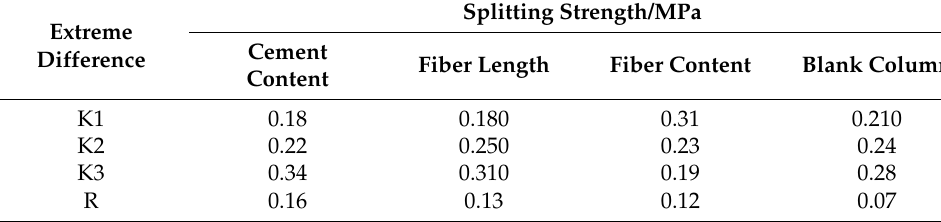
Table 5. Range analysis